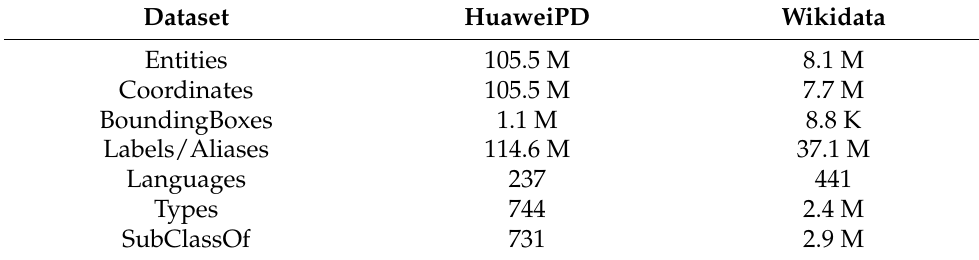
Table 1. Dataset